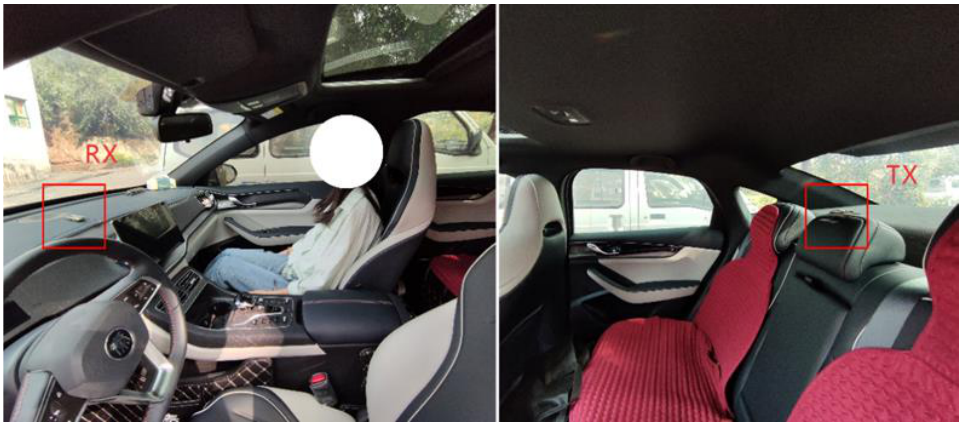
Figure 9. Vehicle interior equipment deployment.